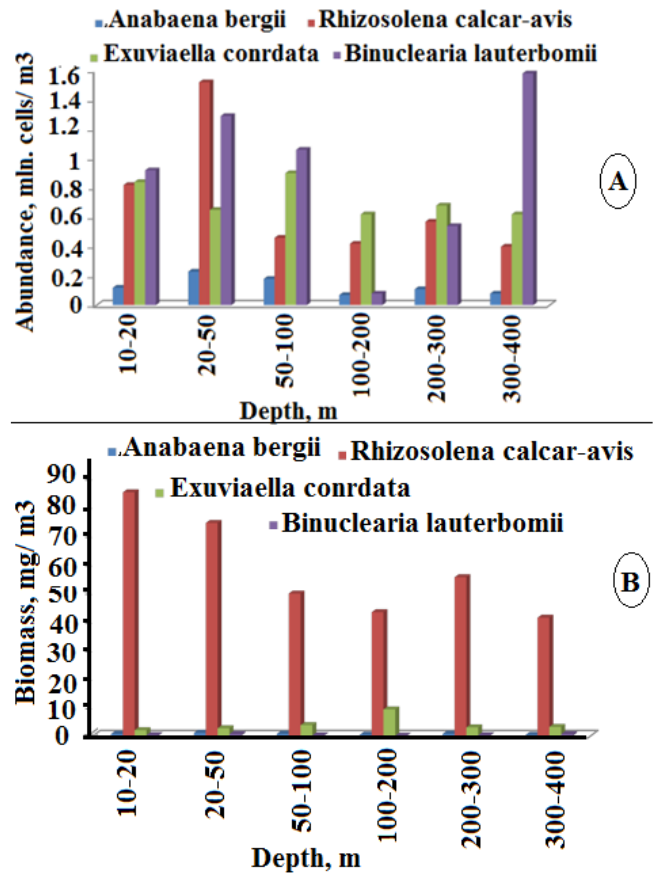
Figure 3. Change in the number ( A ) and biomass ( B ) of background phytoplankton species depending on the depth of the eastern section of the Middle Caspian, 2014. Table 5. Comparative characteristics of the phytoplankton structure in the eastern part of the Middle